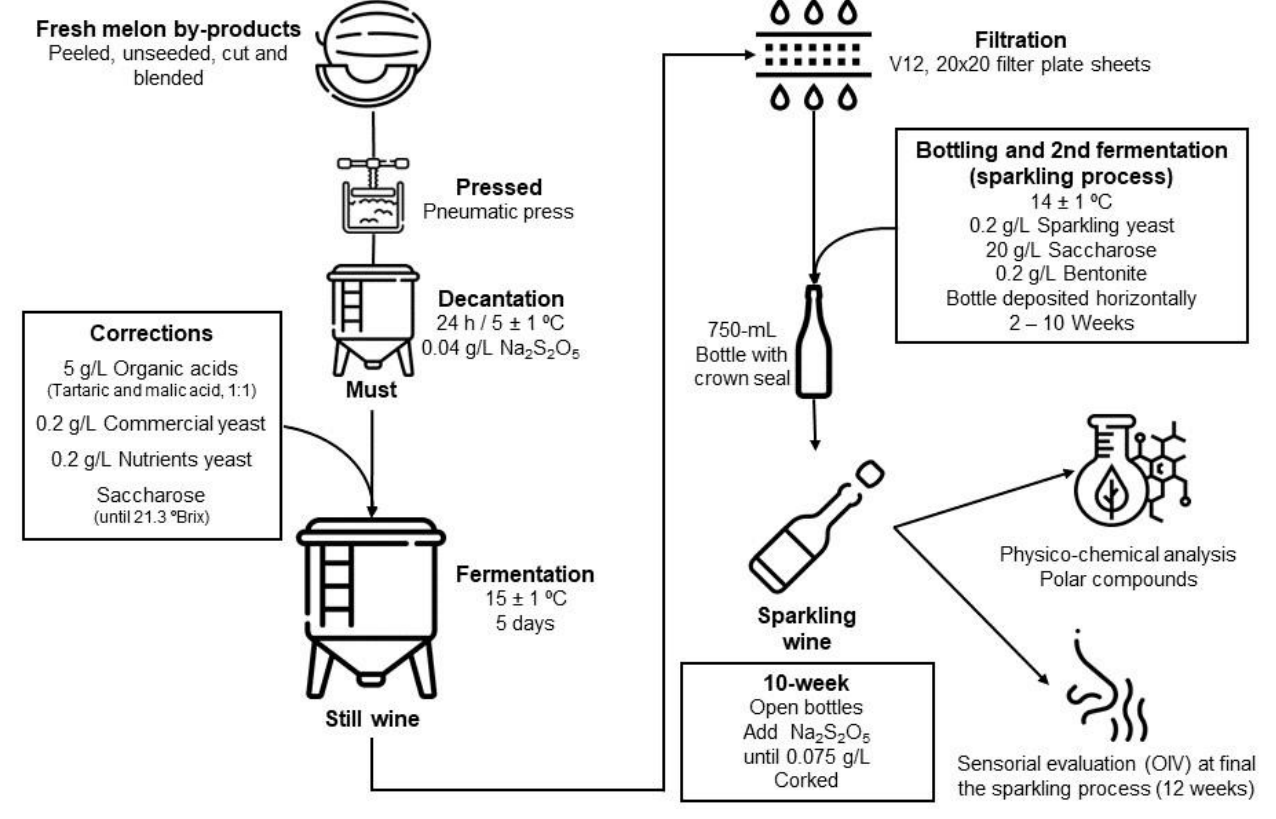
Figure 1. Scheme of the production of melon wine and sparkling wine.